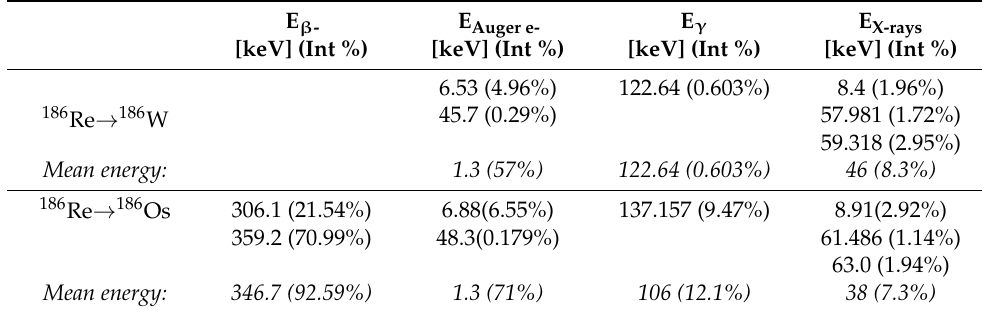
Table 1. 186 Re detailed nuclear decay data [7,9].